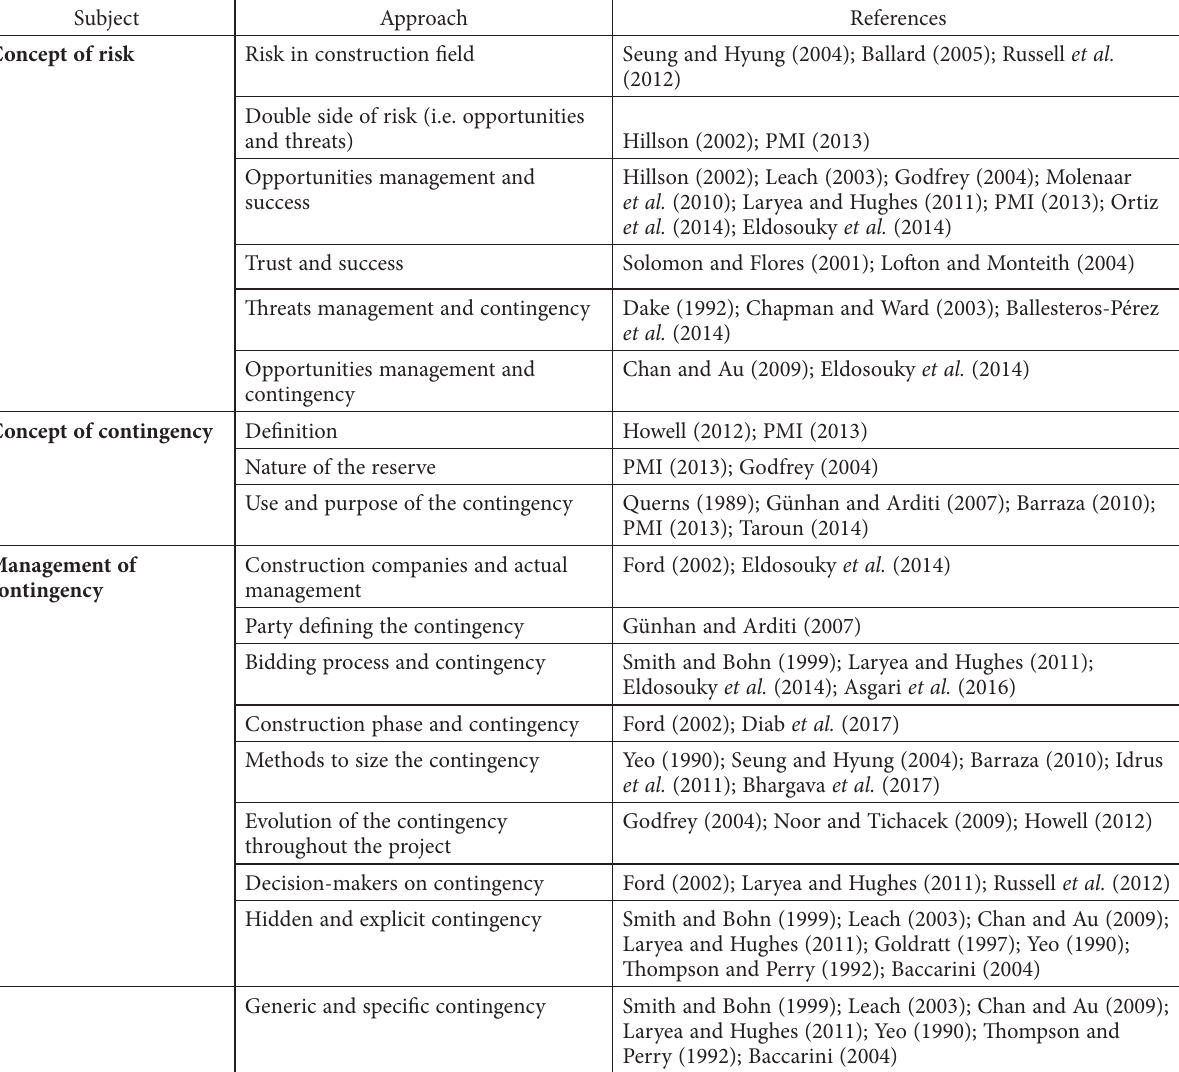
Table 1. Summary of